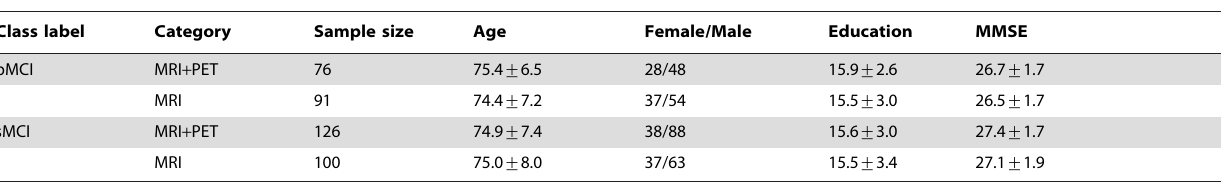
Table 1. Summary of subject information.